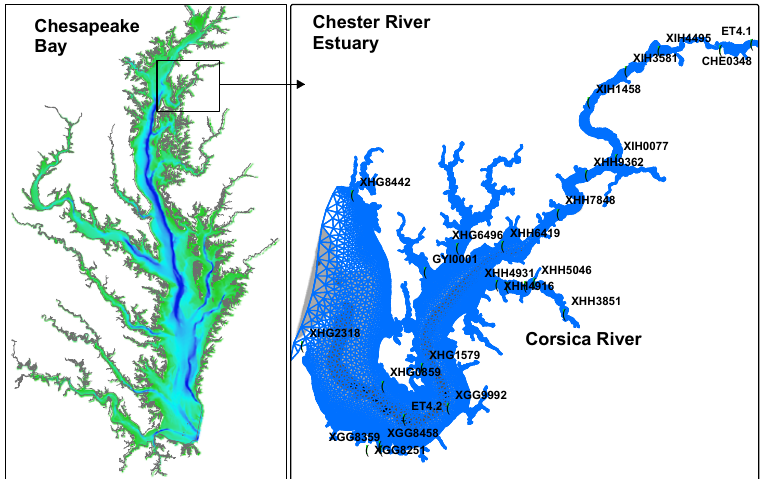
Figure 1. Geographic location, grids, bathymetry, and observation stations in the simulation domain. Left ‐ hand panel is the Chesapeake Bay and right ‐ hand panel is the Chester River estuary. Dark background indicates deep area up to 50 m in the Chesapeake Bay and 18 m in the Chester River estuary.